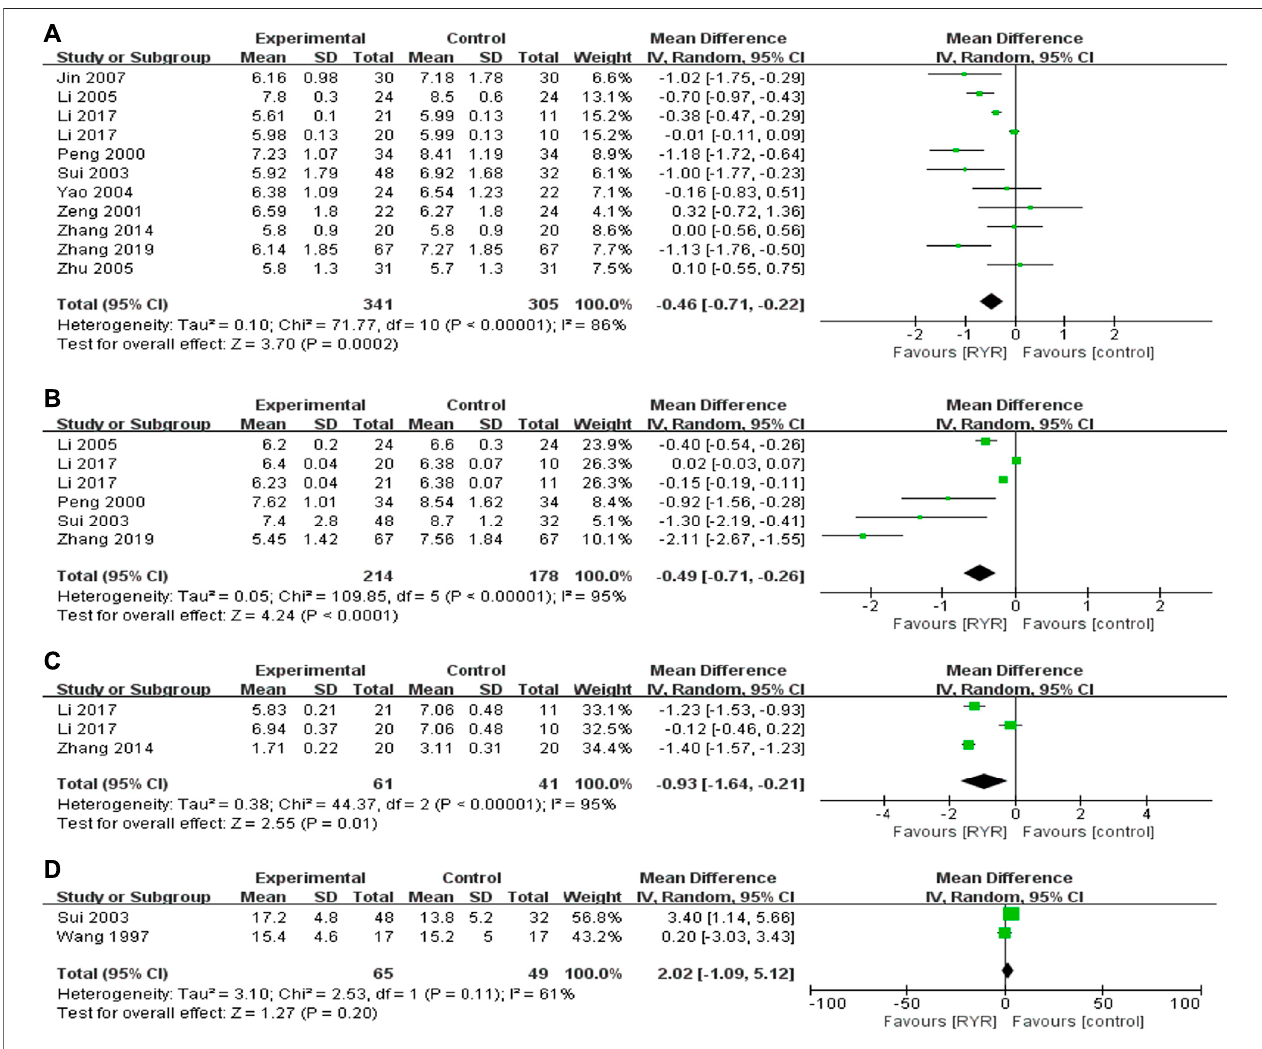
FIGURE 3 | Forest plots of (A) FPG, (B) HbA1c, (C) HOMA − IR, and (D) ISI.